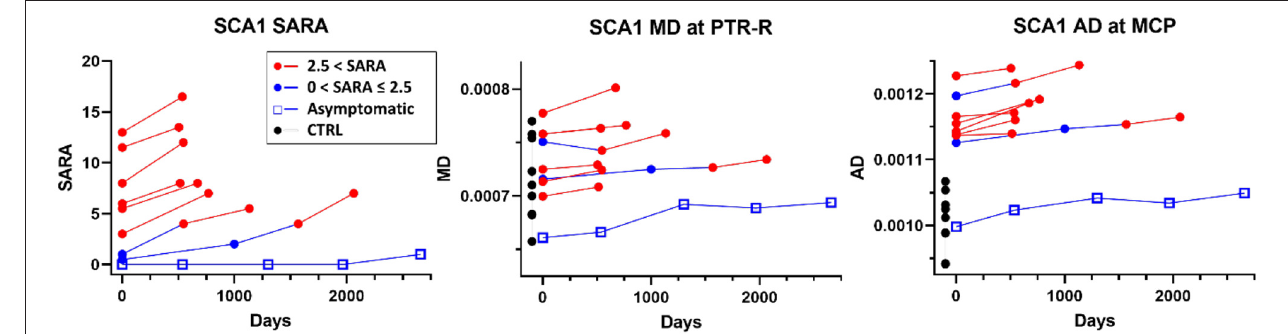
FIGURE 6 | Results of longitudinal ROI-based analysis. Significant changes (slope different than 0) were detected for mean diffusivity (MD) in the right posterior thalamic radiation (PTR-R) and for axial diffusivity (AD) in the middle cerebellar peduncle (MCP) in SCA1. The data acquired from participants at pre-manifest stages are indicated in blue, with a single premanifest patient, who remained at Scale for the Assessment and Rating of Ataxia (SARA) < 2 throughout the study indicated with blue open squares. Black circles indicate values from healthy controls in the same regions. SARA scores of the same patients are shown on the